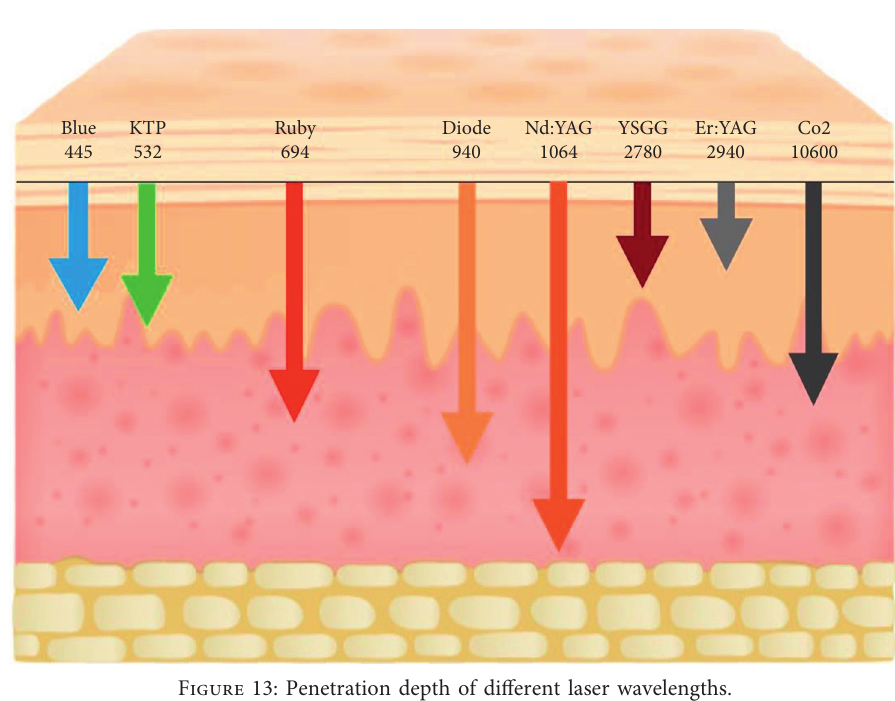
Figure 13: Penetration depth of different laser wavelengths.